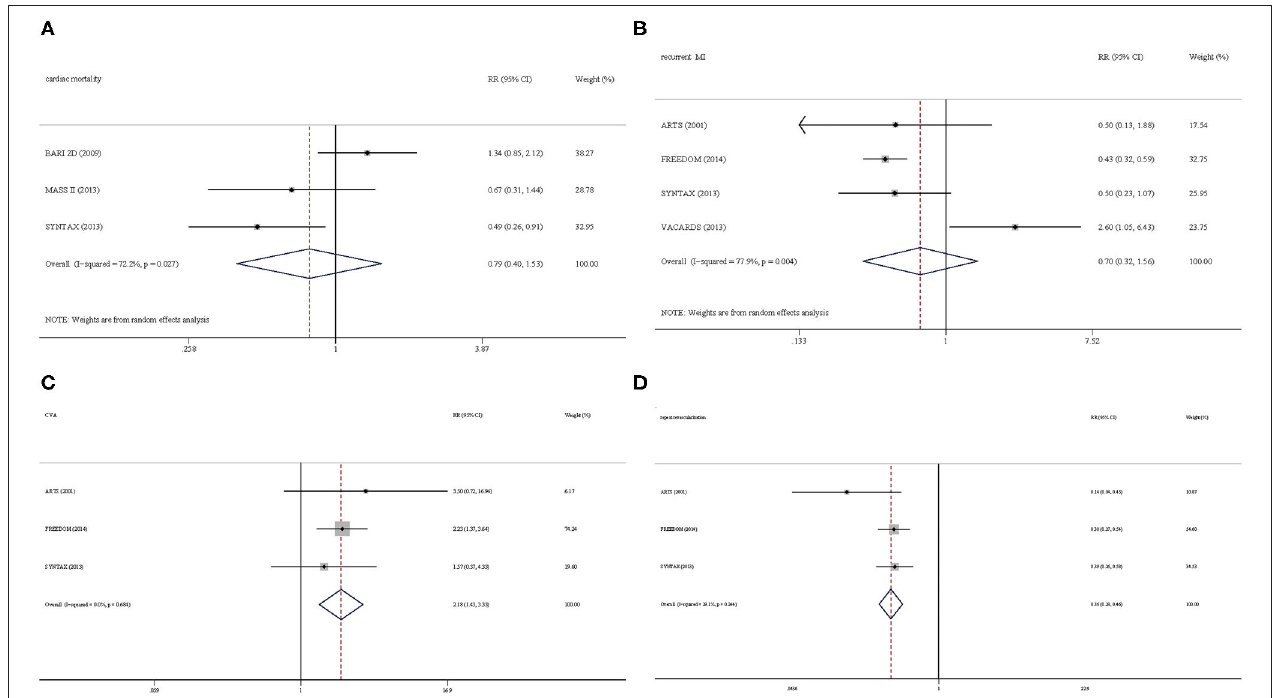
FIGURE 4 | Secondary outcomes. (A) Cardiac mortality. (B) Recurrent myocardial infarction. (C) Cerebralvascularaccident. (D) Repeat